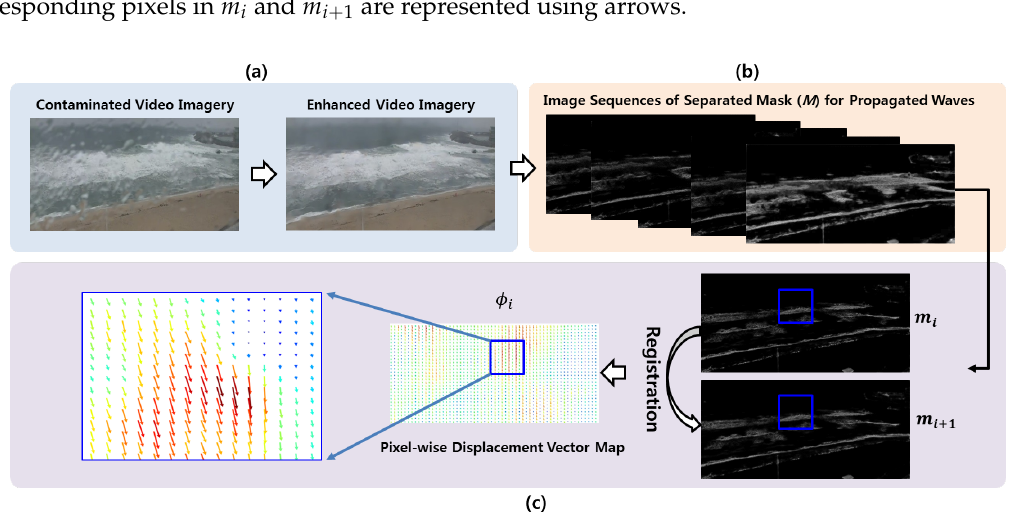
Figure 5. Samples of results according to three procedures for wave-tracking: ( a ) video enhancement, ( b ) hydrodynamic scene separation, and ( c ) unsupervised image